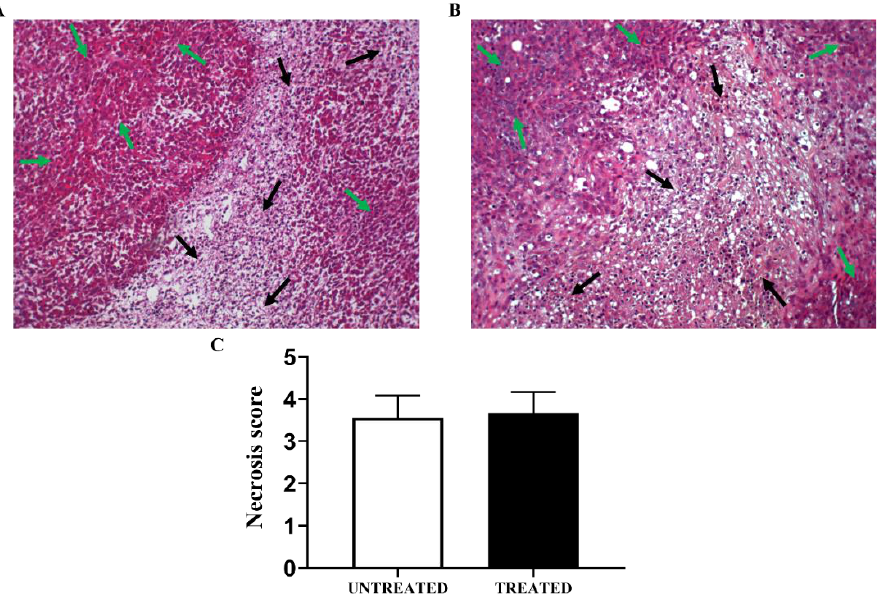
Figure 7. Representative hematoxylin and eosin tumor sections for the PC3 subcutaneous tumor model showing regions of viable tumor (green arrows) and of highly-diffused necrosis (black arrows) in one week of treatment ( A ) and untreated ( B ) PC3 tumors. Bar graph of calculated tumor necrosis score in untreated and treated tumors ( C